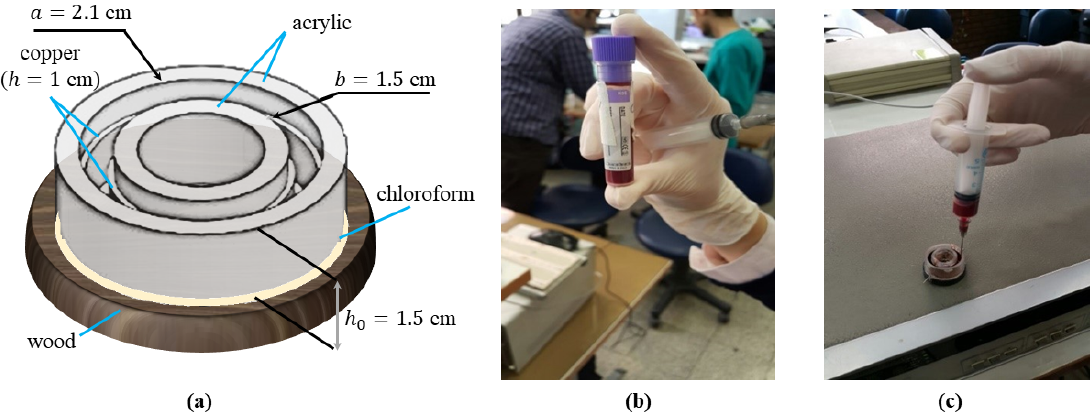
Figure 1. ( a ) Schematic model of the designed device and the main dimensions. ( b ) Two cubic centimeters (cc) of blood samples in an EDTA tube. ( c ) Cylindrical capacitor with a volume of two cc and collected blood samples as its dielectric